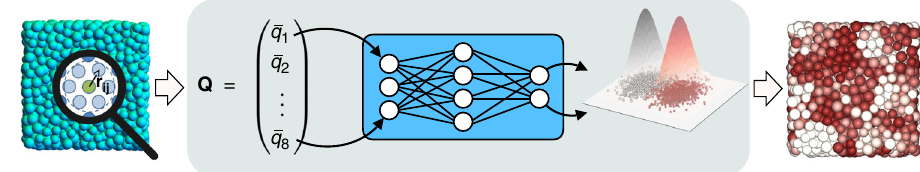
Fig. 1 Schematic representation of the unsupervised machine learning method. In this method, the local environment of a particle is encoded in a vector ( Q ) of bond-order parameters, which is used as the input for an arti fi cial neural network trained to reduce its dimensionality. The resulting distribution of particle environments in the lower dimension is clustered using a Gaussian mixture model. Finally, particles are assigned a probability of belonging to one of the two clusters, and colored